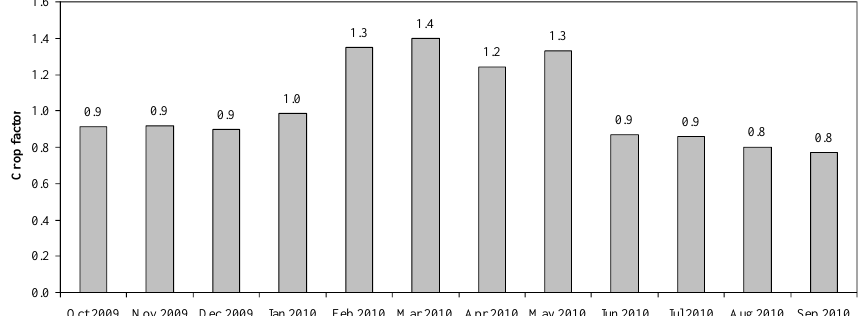
Figure 10. Monthly crop factors K c for the Nkazana Peat Swamp